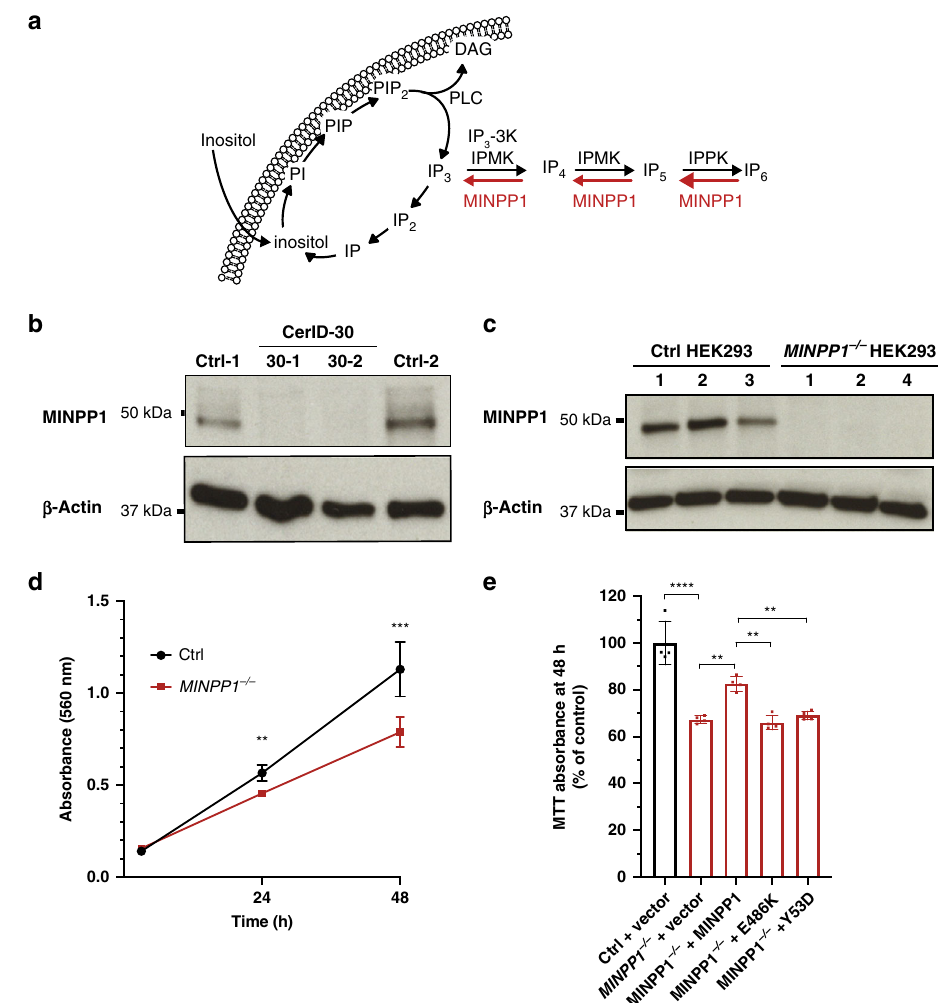
Fig. 2 PCH-associated mutations of MINPP1 are deleterious for protein function. a Schematic representation of inositol phosphate cycle. myo- inositol (Inositol); phosphatidylinositol (PI); phosphatidylinositol phosphate (PIP); phosphatidylinositol 4,5-bisphosphate (PIP 2 ); diacylglycerol (DAG); phospholipase C (PLC); inositol phosphate (IP); inositol bisphosphate (IP 2 ); inositol 1,4,5-trisphosphate (IP 3 ); inositol 1,3,4,5-tetrakisphosphate (IP 4 ); inositol pentakisphosphate (IP 5 ); inositol hexakisphosphate (IP 6 ); inositol-polyphosphate multikinase (IPMK); I(1,4,5)P 3 3-Kinase (IP 3 -3K); inositol- pentakisphosphate 2-kinase (IPPK); multiple inositol-polyphosphate phosphatase 1 (MINPP1). b , c Western blot analysis of MINPP1 level in patient fi broblasts and HEK293 cells with β -Actin shown as loading control. Patient fi broblasts CerID-30-1 and CerID-30-2 ( b ) and MINPP1 − / − HEK293 clones ( c ) show absent MINPP1. The uncropped blots are provided as a source data fi le and are representative of two independent experiments. d Assessment of